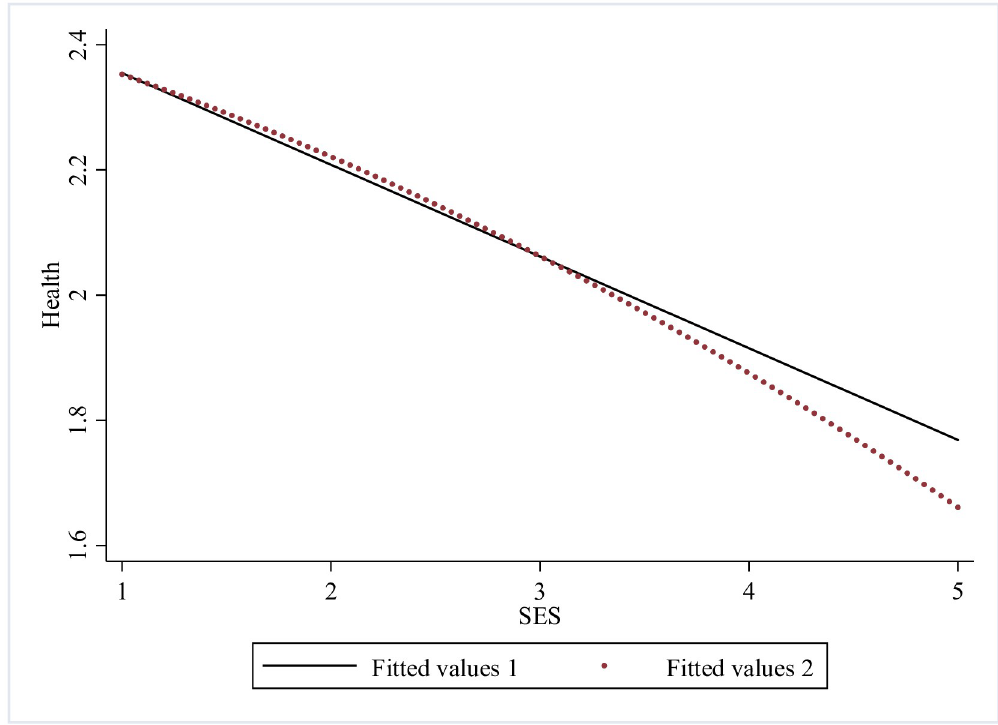
Fig 3. Fitting relationship between SES and